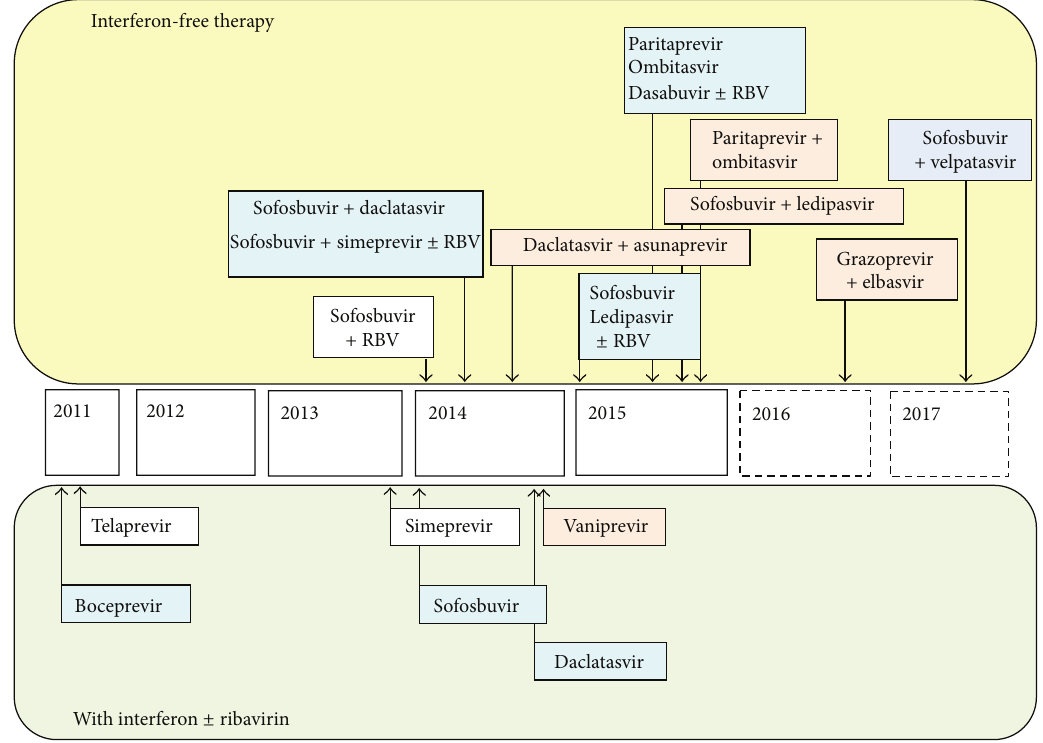
Figure 1: Treatment of HCV with DAAs that are approved or are going to be